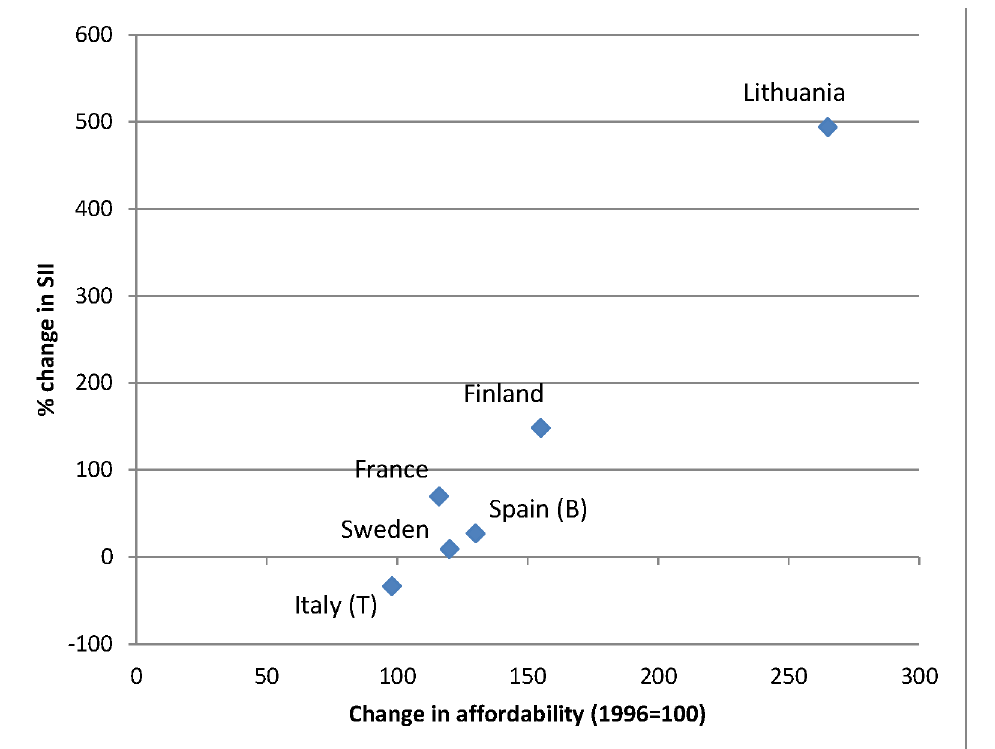
Fig 12. Change in alcohol affordability between 1996 and 2004 versus change in absolute inequality in alcohol-related mortality among women between ca. 1990 – 1994 and ca. 2005 – 2009. Data on affordability are from Rabinovich et al. [59] and give levels of affordability relative to that observed in 1996. Only countries with both data on affordability and data on SII for ca. 1990 – 1994 and ca. 2005 – 2009 are included in this graph. A change in affordability > 100 indicates that, as a result of increasing income and/or decreasing price, alcohol has become more affordable. B, Barcelona; T,